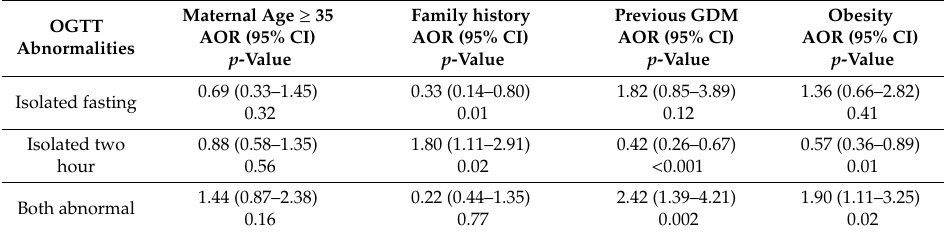
Table 4. Associations between maternal risk factors and OGTT